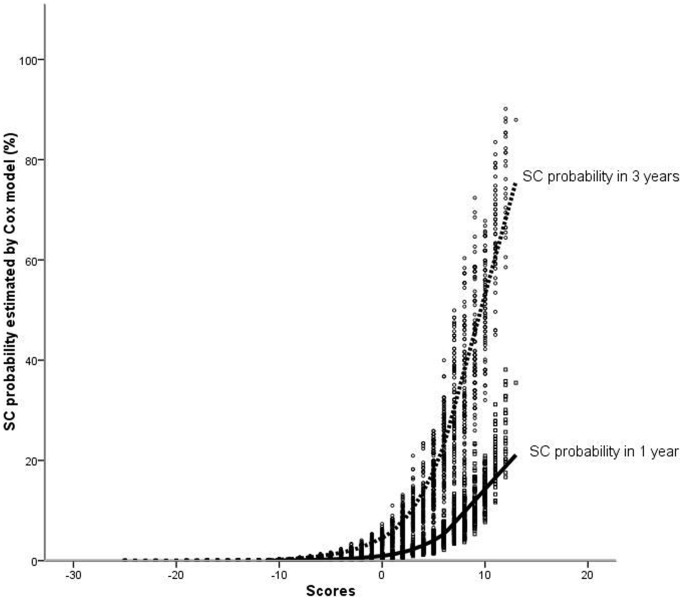
Plots show SC probabilities occurring within 1 year(□) and 3 years(○) among PMVSD patients in the derivative cohort, plotted against the scoring system.The LOESS fit lines (the solid line for 1-year and the dashed line for 3-year) using 50% fit plots show the trend of SC probability against the score. (SC, spontaneous closure).